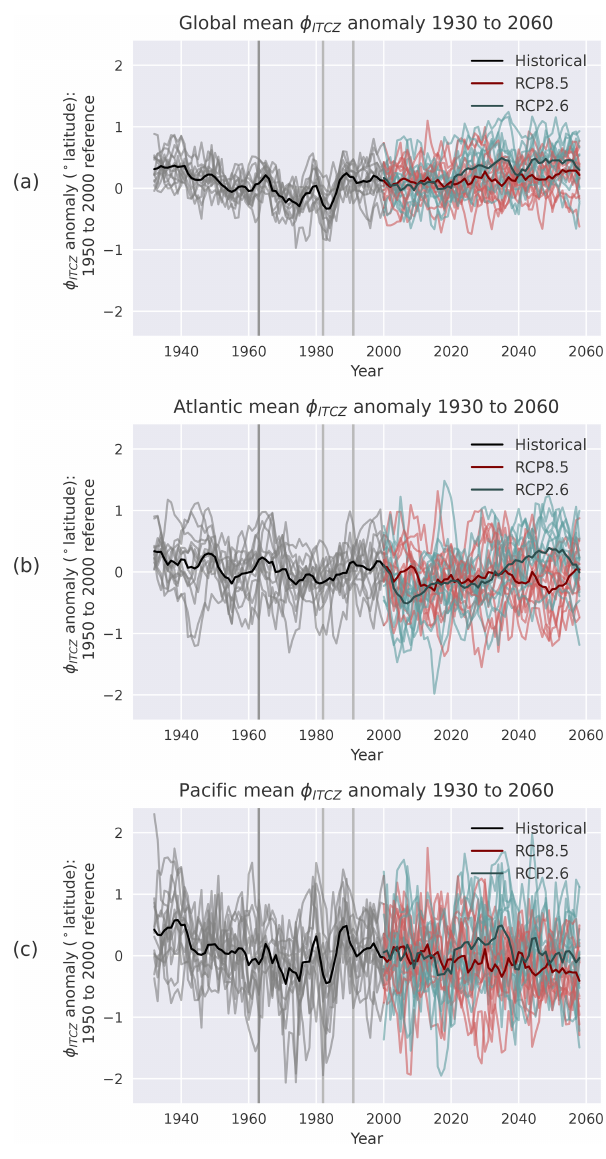
Figure 3. Time series of 5-year rolling mean (cid:56) ITCZ anomaly rel- ative to the 1950 to 2000 reference period for (a) global, (b) At- lantic, and (c) Pacific regional means. The ensemble mean time se- ries is shown by the darker line, and the individual ensemble mem- bers are shown by the lighter lines. Major volcanic eruptions are marked with grey vertical lines with maximum aerosol loading in the NH – El Chichón (1982, Mexico, 17.21 ◦ N) and Pinatubo (1991, Philippines, 15.08 ◦ N) – and in the SH (Mt Agung, 1963, Indonesia, 8.20 ◦